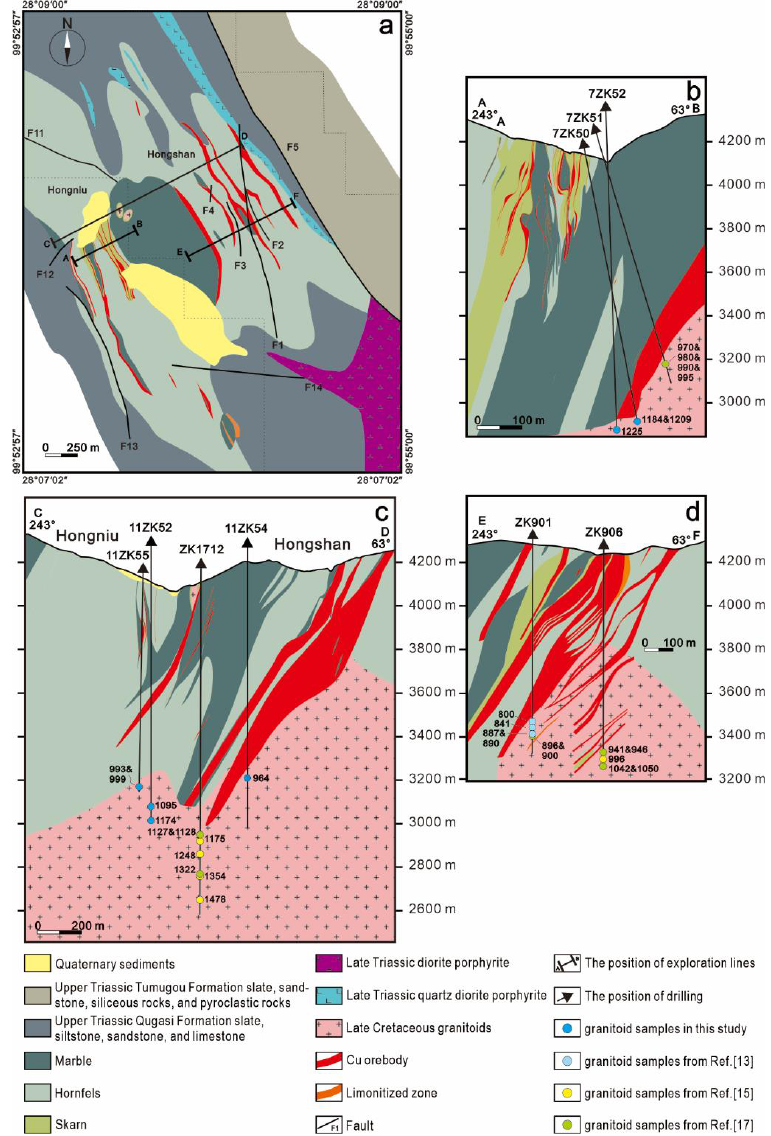
Figure 2. ( a ) Geological map of Hongniu-Hongshan porphyry copper deposit modified according to the geological report and Peng et al. [36]; ( b ) Profile of the Hongniu-7 exploration line; ( c ) Profile